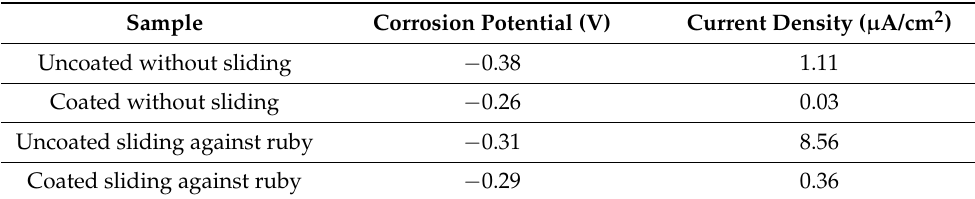
Table 4. Potential and current density values obtained from the potentiodynamic polarization tests for uncoated and coated samples with and without sliding against ruby balls.